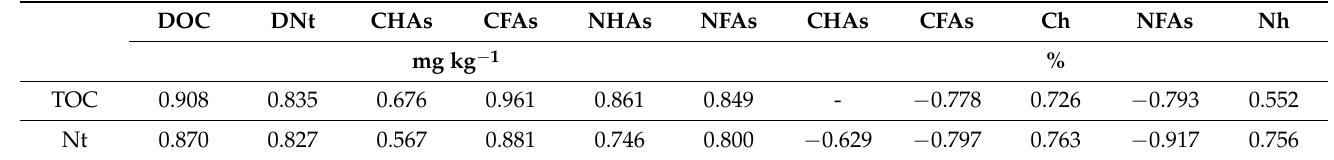
Table 3. Significant correlation coefficients ( p ≤ 0.05) between the TOC and Nt content (g/kg) and fractional composition of